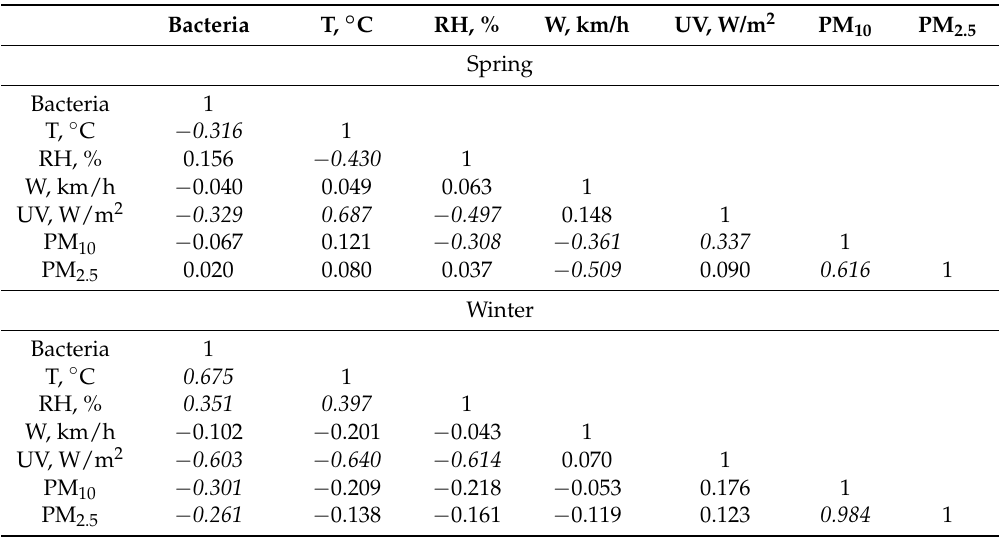
Table 2. Spearman correlation coefficients between bacterial aerosol concentrations and environmental parameters ( n =